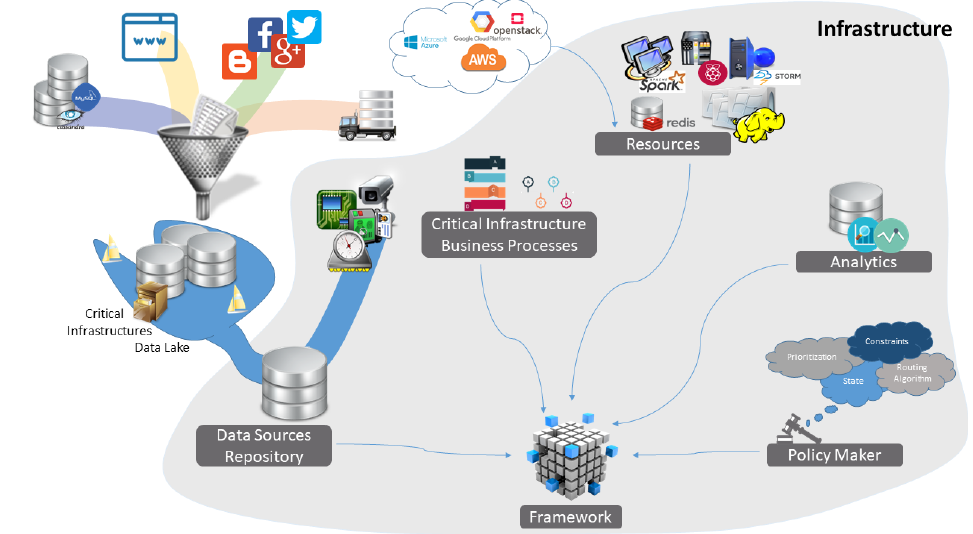
Figure 5. Critical Infrastructure